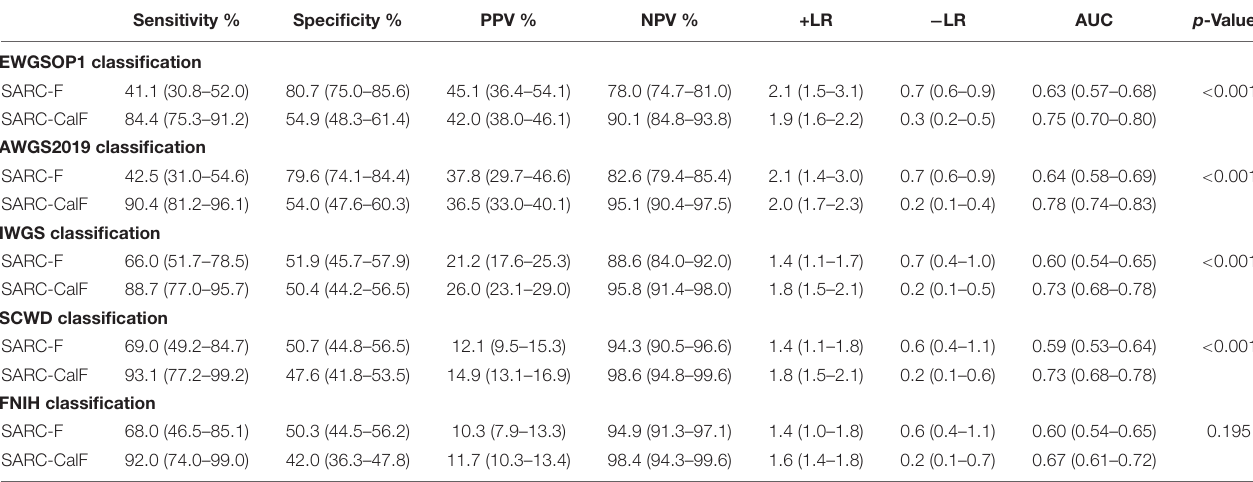
TABLE 6 | Sensitivity, specificity, PPV, VPN, +LR, and − LR tests and ROC curves for SARC-F and SARC-CalF validation against various sarcopenia criteria in the older